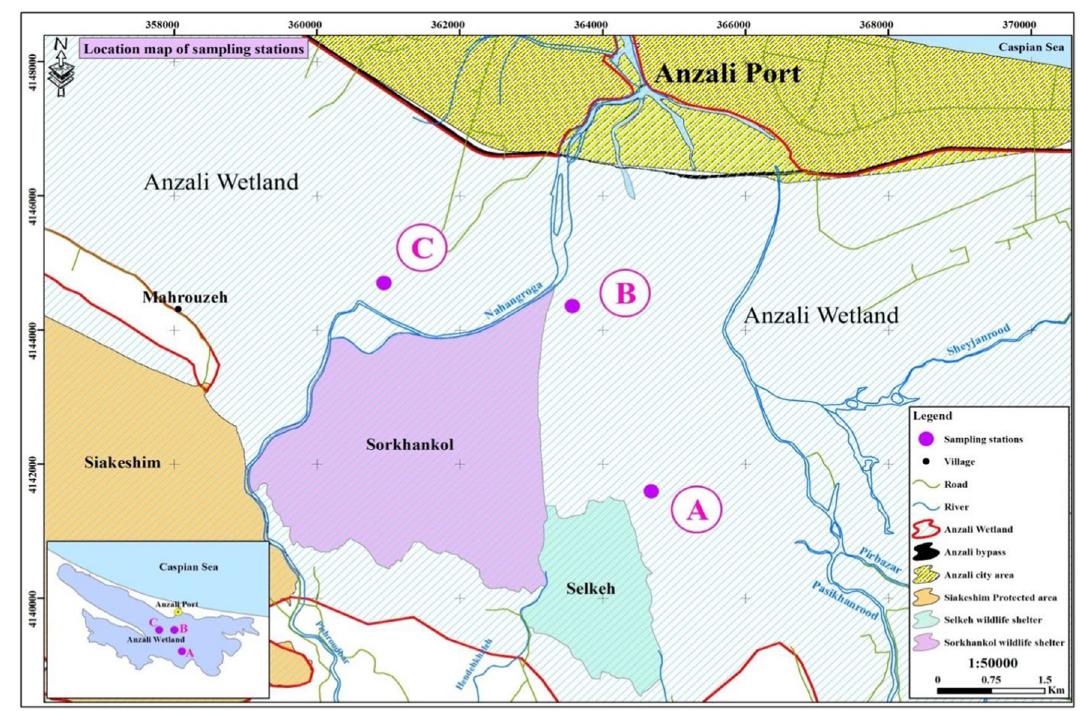
Fig. 1 Map of study areas with indication of the sampling sites in three parts of the Anzali wetland ( a eastern part, b central part, c western